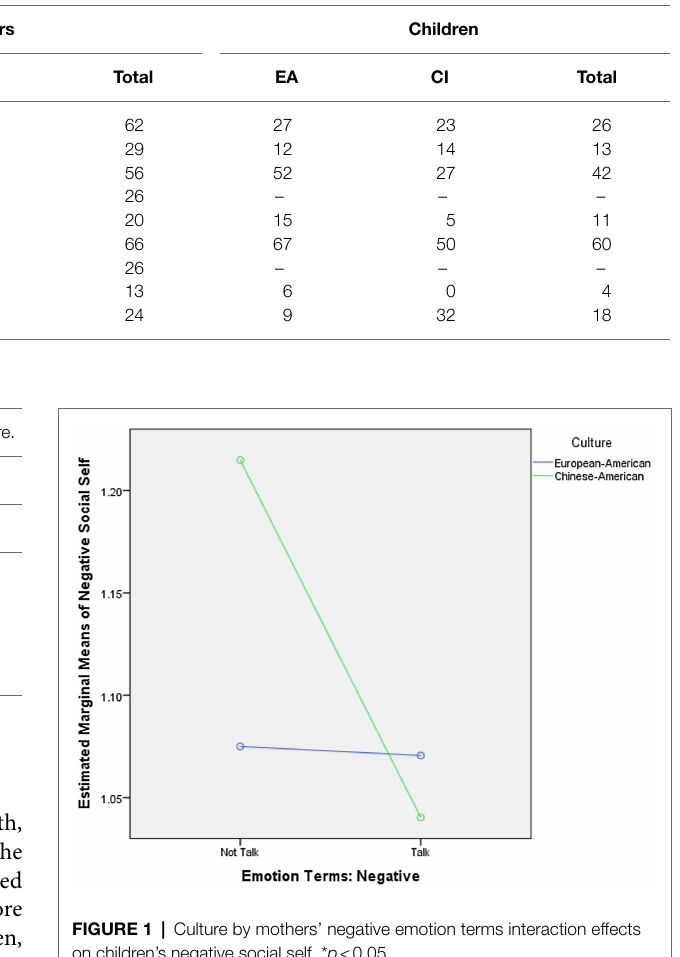
FIGURE 1 | Culture by mothers’ negative emotion terms interaction effects on children’s negative social self. * p <